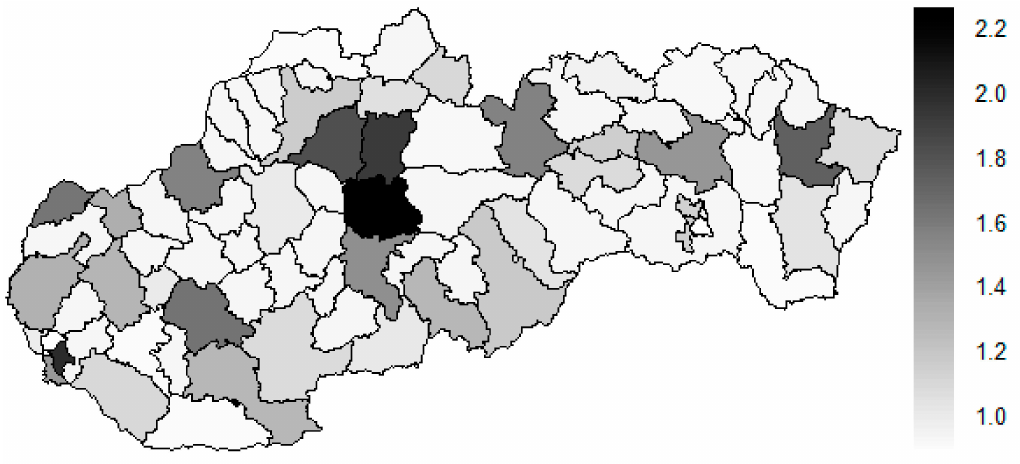
Figure 11. Modified medical equipment similarity map of the districts in the year 2015. Source: own elaboration by the authors.